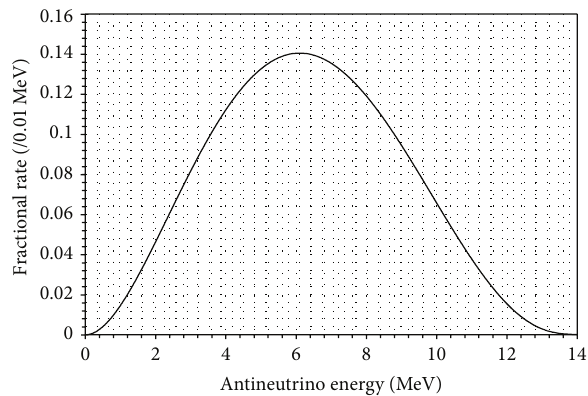
Figure 2: The 8 Li isotope DAR anti-electron-neutrino flux.